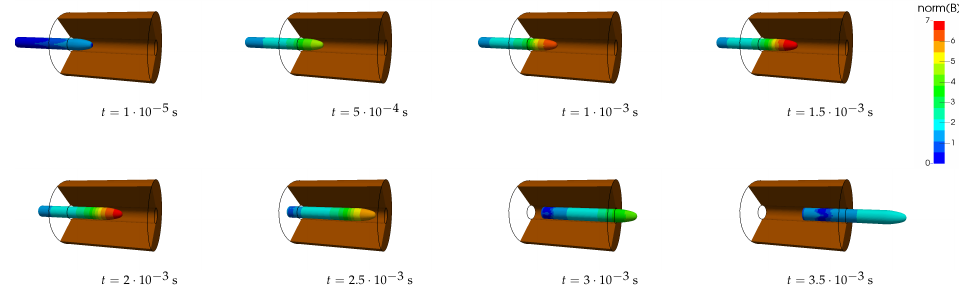
Figure 12. Different snapshots of the electromagnetic launcher, projectile is coloured by the magnitude of the B -field (max =